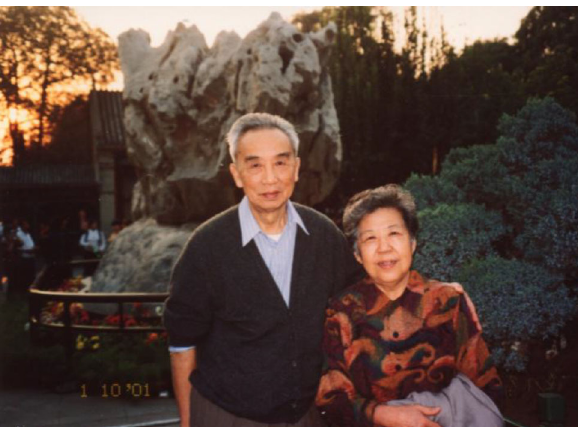
Figure 3. Jilun Li and his wife, Prof. Fanjing